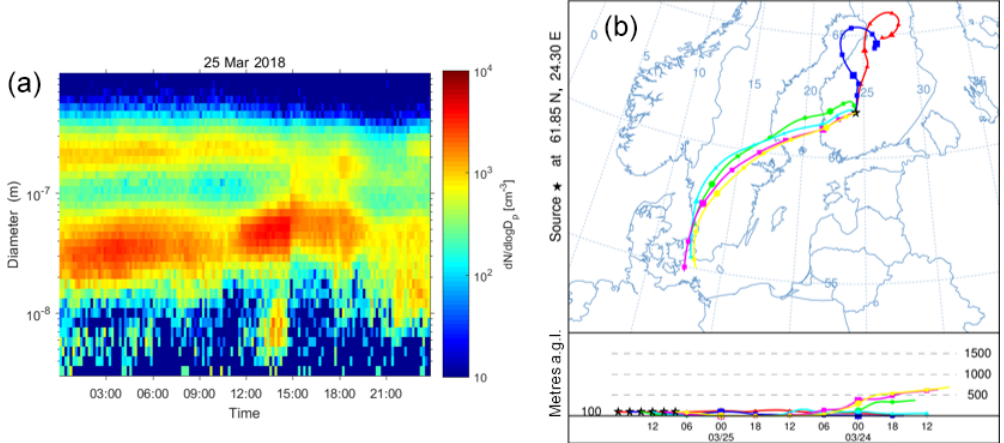
Figure 8. (a) Time series of the particle number size distribution as measured by the local DMPS. (b) Backward trajectories calculated using the HYSPLIT model, extending 48h back in time. Both panels depict 25 March